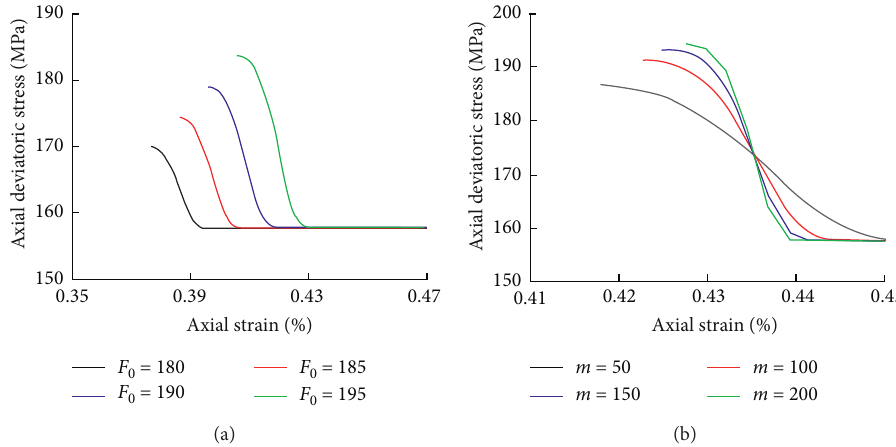
0 ; (b) different m .